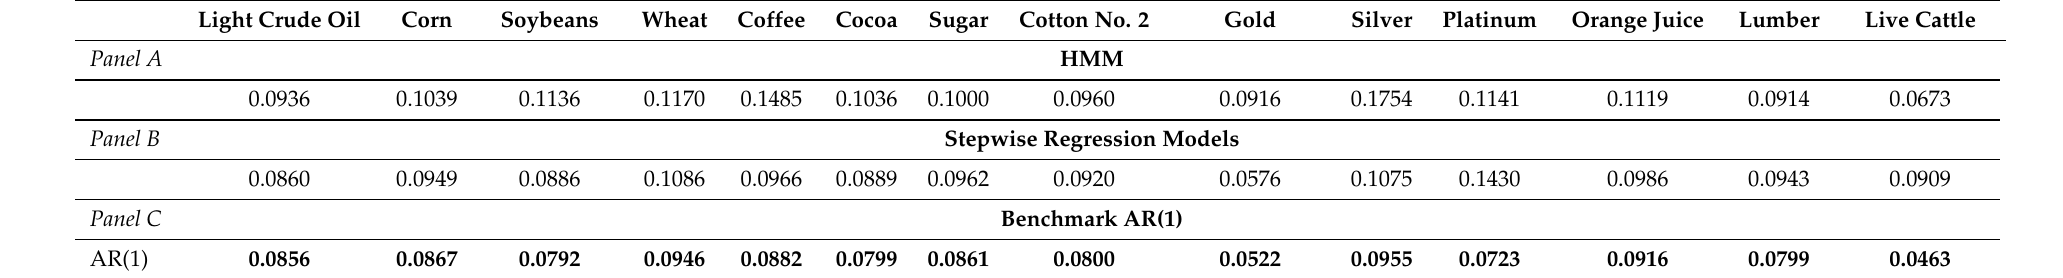
Table 5. Root mean square error forecast performances—Markov switching vs. stepwise regression models, equally weighted. The table compares the RMSFE statistics implied by an equally-weighted average of the forecasts obtained from the three HMM and the 24 stepwise (forward and backward) predictive regression models recursively implemented in our analysis. In particular, the table obtains the forecasts by weighting (over the entire OOS period, January 2004–May 2018) the regime-specific stepwise regression forecasts by the predicted regime probabilities obtained from a two-state HMM for the VIX index. In the different panels we have boldfaced the forecasting model that yields the minimum